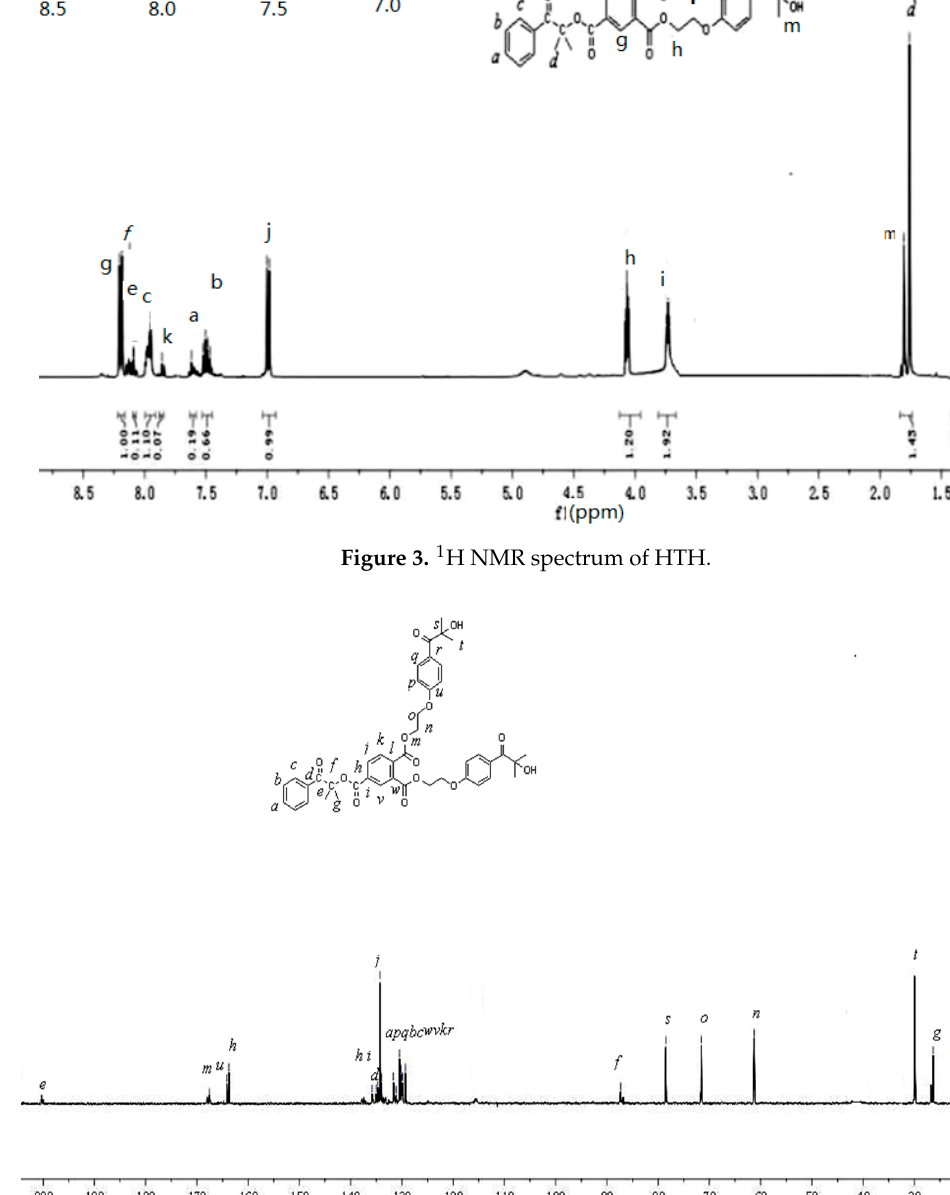
Figure 4. 13 C NMR spectrum of HTH.